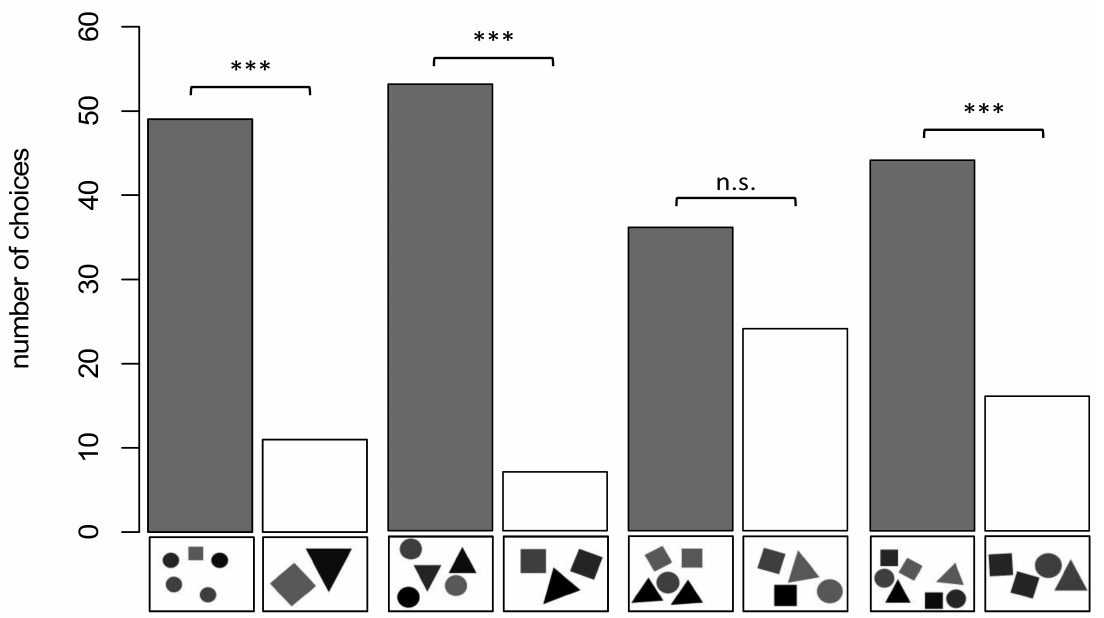
Figure 6. Overview of shark group 1 results in the transfer tests. On the X-Axis exemplary stimulus-pairs are displayed. The dark bars represent the correct choice for higher numerosity. p > 0.05 not significant (n.s.), p < 0.001 significant